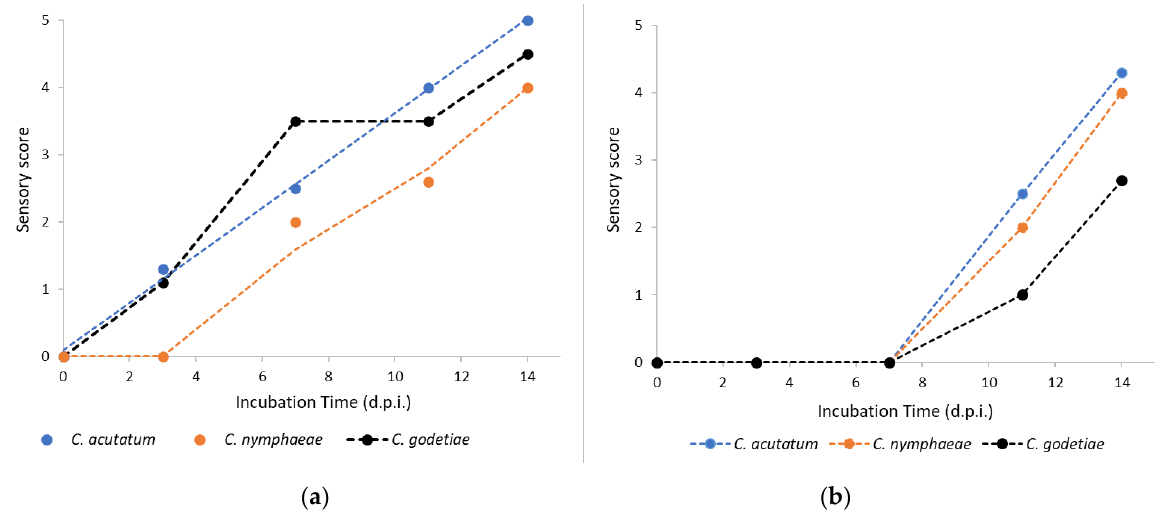
Figure 4. Musty defect score detected in Galega ( a ) and Cobrançosa VOO ( b ) obtained from fruits, after 3, 7, 11, and 14 days post-inoculation (d.p.i.) with Colletotrichum acutatum , C. nymphaeae, and C. godetiae.